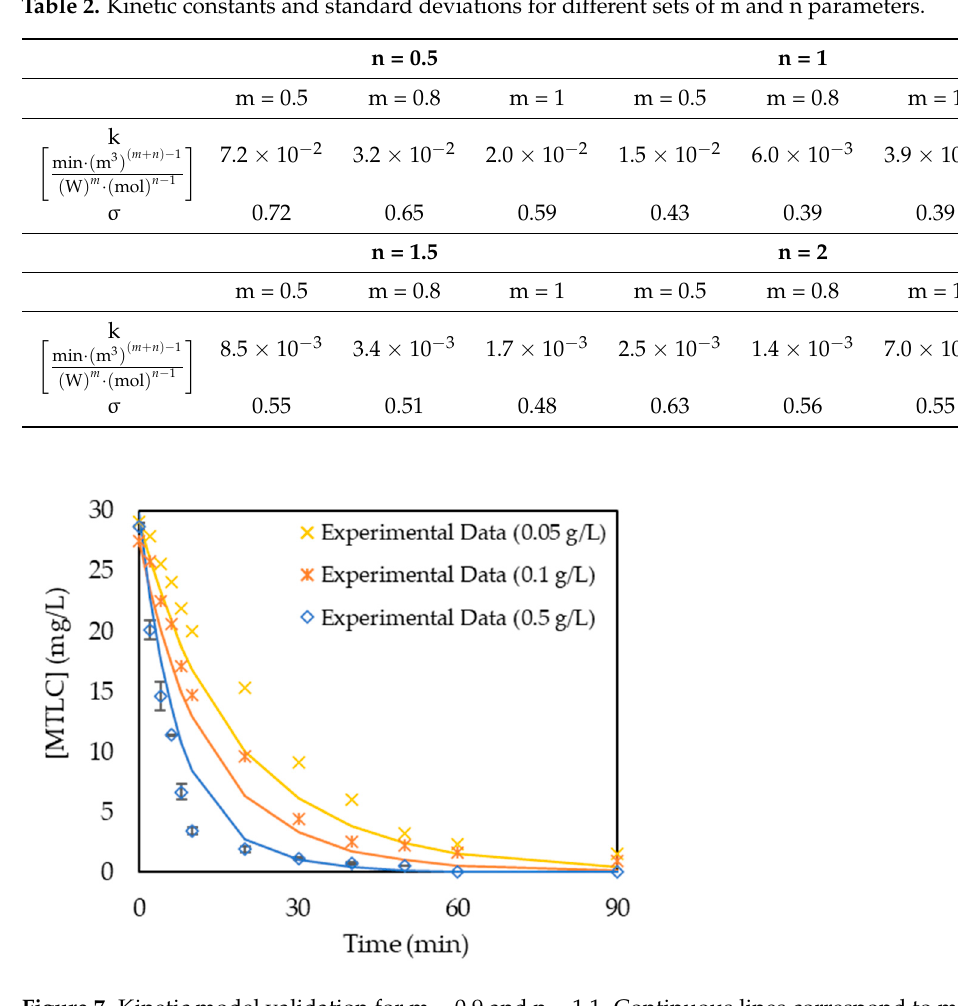
Figure 7. Kinetic model validation for m = 0.9 and n = 1.1. Continuous lines correspond to model simulations.